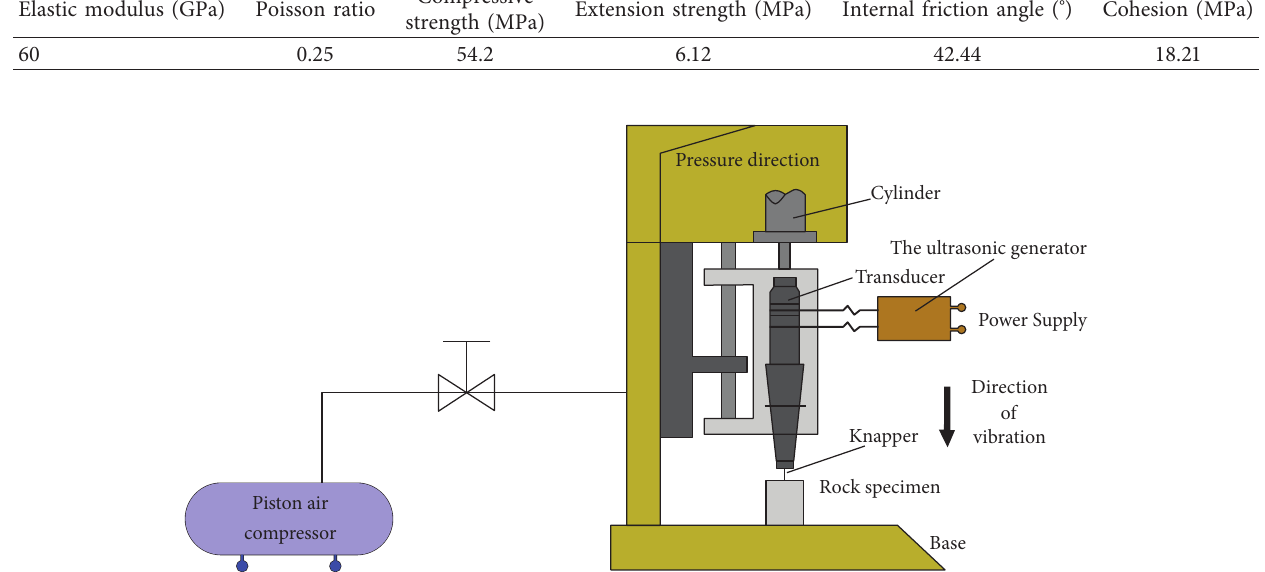
Figure 1: Schematic of ultrasonic vibration inducer.